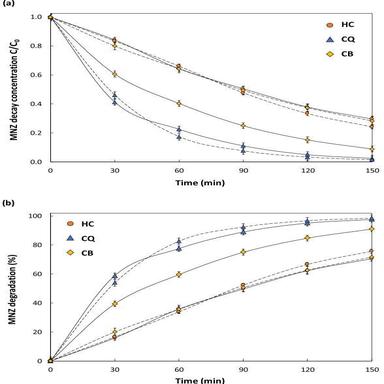
Degradation kinetics of metronidazole by heterogeneous EF treatment using two approaches for the catalyst immobilization in the cathodes prepared with different carbon materials: solid lines: "pre" series; dashed lines: "post" series. BDD as anode, 0.05 M Na2SO4 electrolyte, 100 mg L− 1 of metronidazole, applied potential − 0.75 V vs Ag/AgCl. Experimental data is shown as: (a) relative decay concentration of metronidazole, and (b) removal percentage.